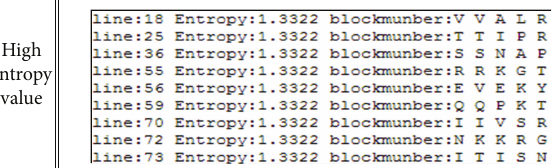
Figure 12: Example of showing high entropy value at the specific